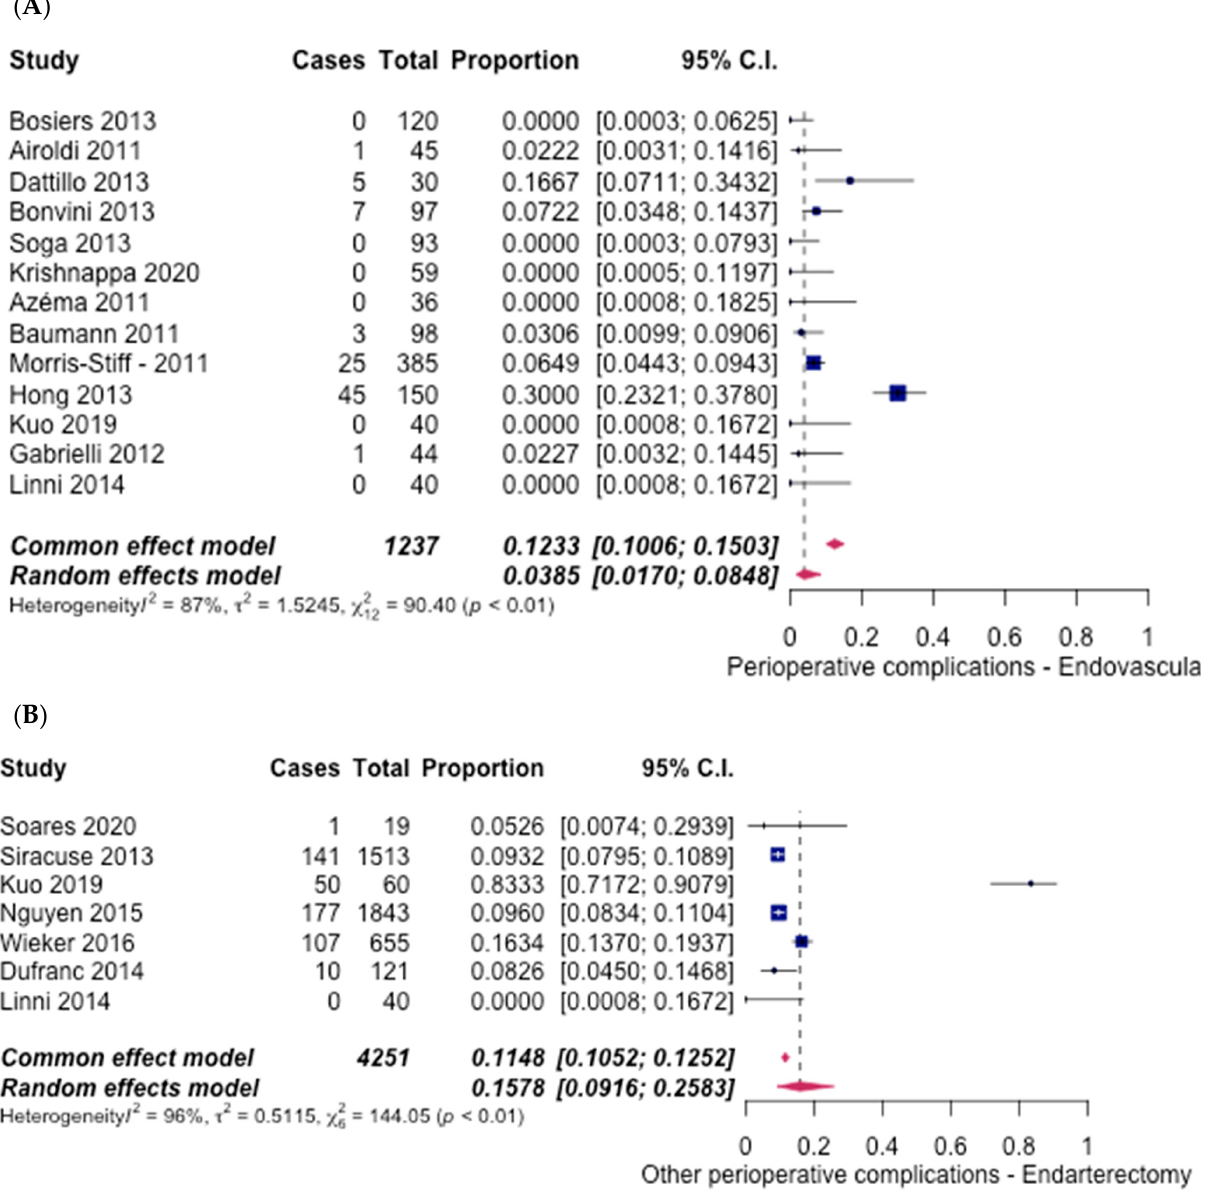
Figure 15. Forest plot for other perioperative complications. ( A ) Endovascular intervention [6–12,15–17,19–21]. ( B ) Endarterectomy [6,21–23,25,28,29]. Fifteen studies [6–12,15–21] mentioned the need for further surgery in the ET group, and an overall rate of 4.07% (95% CI [2.63%, 6.24%]) (Figure 16A) was noted. Similarly, only seven studies [6,21–25,29] reported the need for further surgery after FAE, with a total rate of only 2.32% (95% CI [0.79%, 6.64%]) (Figure 16B). The difference between the two groups was significant, in favour of FAE, with an odds ratio of 1.79 (95% CI [1.12–2.85], p < 0.05).